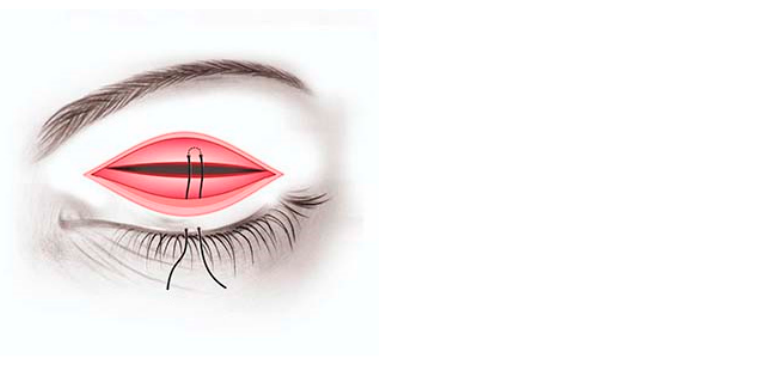
Figure 2. Schematic representation of the suture trajectory: skin (ciliary margin)—upper tarsal plate—skin (ciliary margin) (picture by Speran ț a Schmitzer).